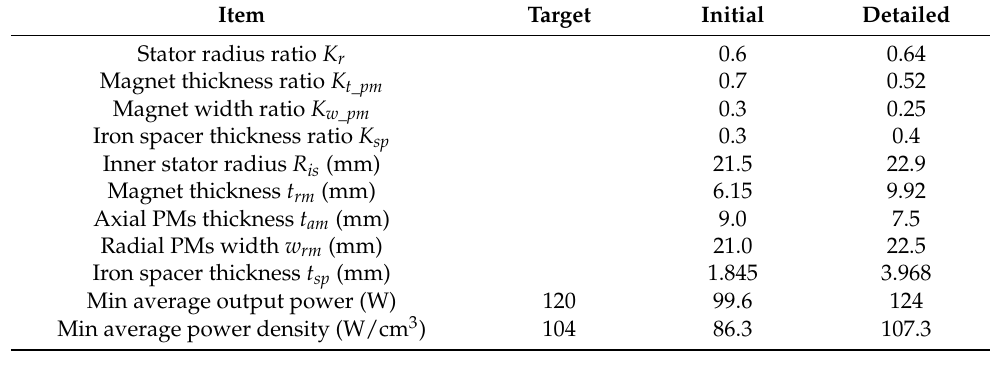
Table 3. Comparison of Initial and Detailed Design.